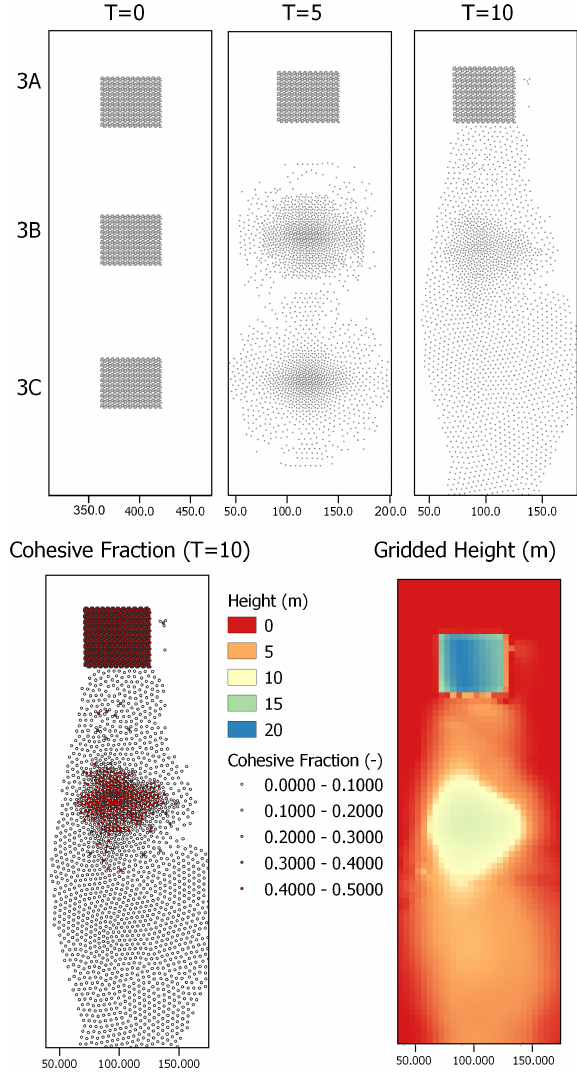
Figure 8. Several time slices for numerical scenarios 3A ,3B and 3C. See Fig. 6 for the dimensions and terrain